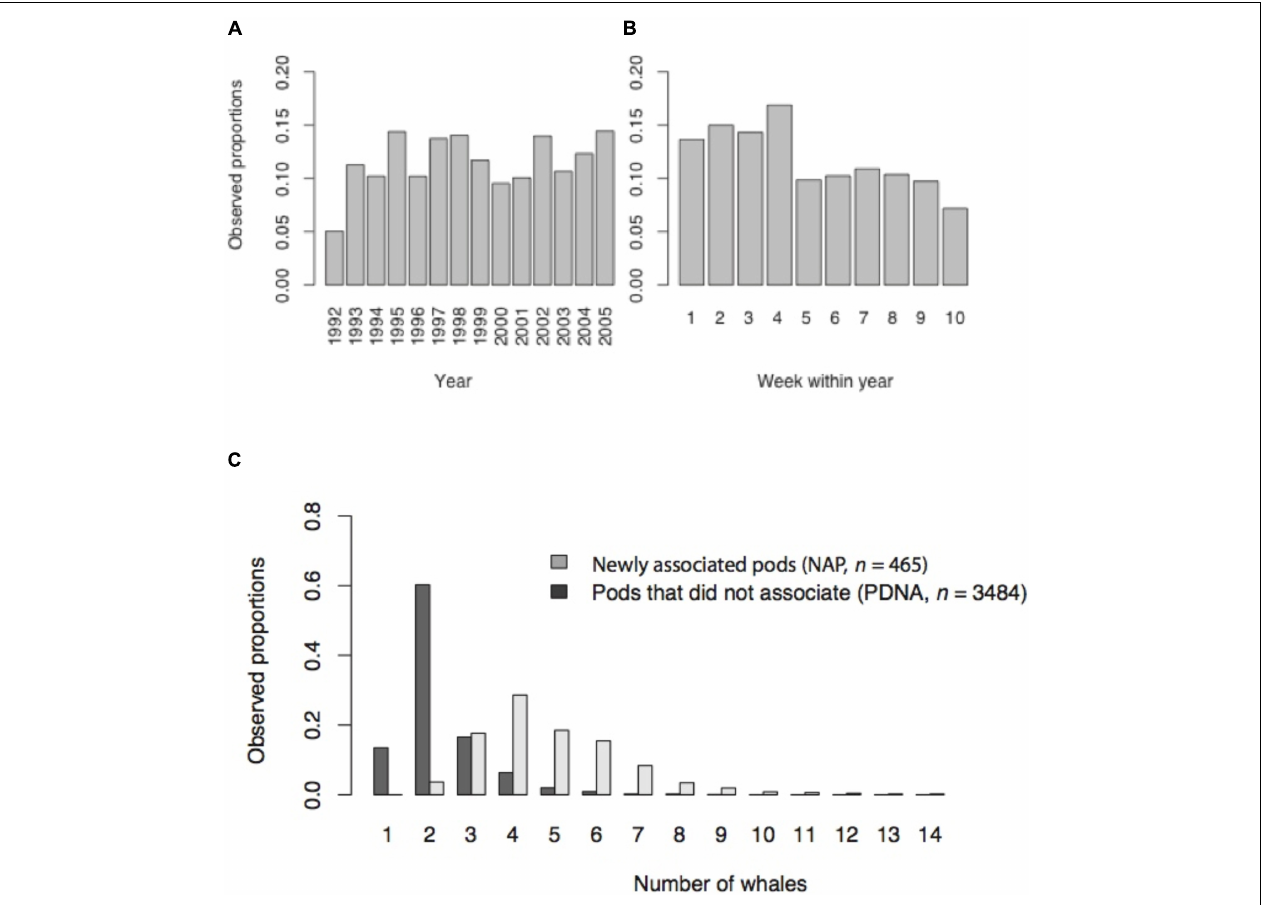
FIGURE 3 | Observed proportions: (A) newly associated pods by year, (B) newly associated pods by week within year, (C) pods by number of whales in pods for newly associated pods (NAP) and pods that did not associate while under observation (PDNA).